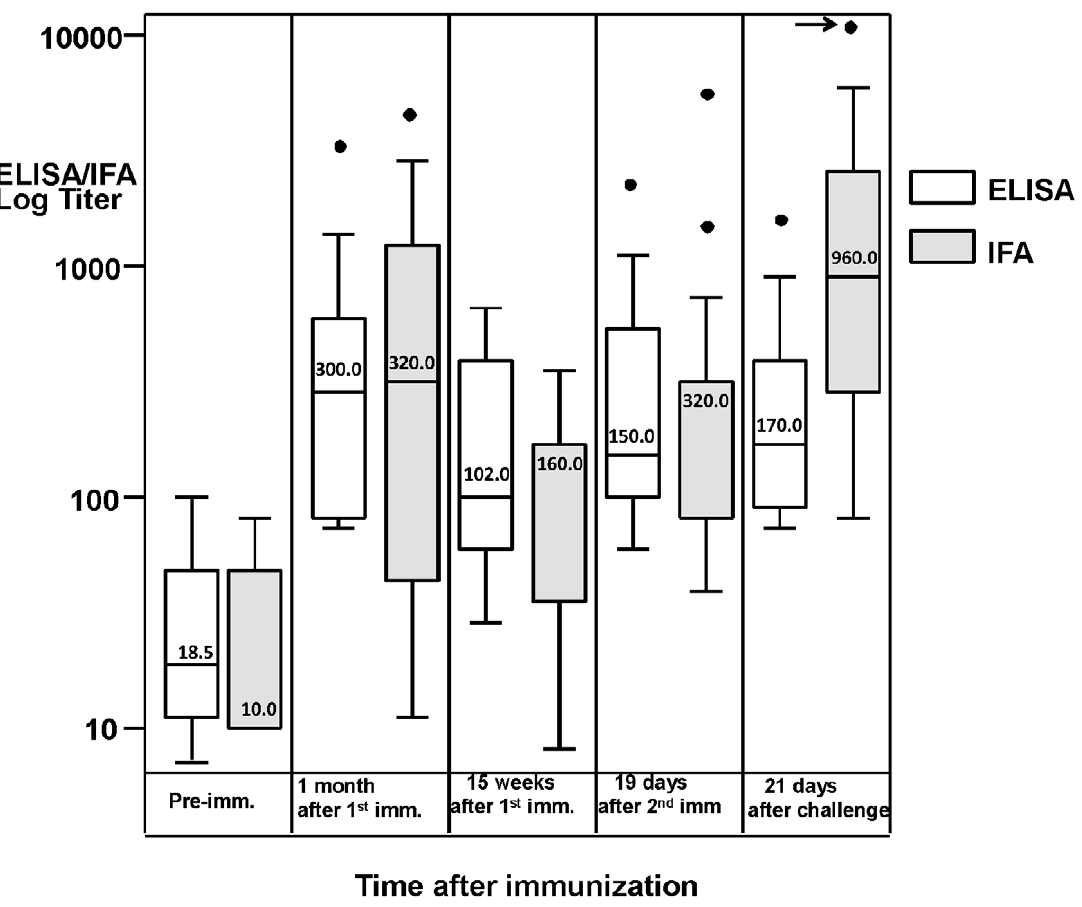
Figure 7. CSP ELISA and Sporozoite IFA activity. Box plots of the medians (50 th percentile) and 25 th and 75 th percentiles of ELISA and IFA activities prior to immunization, at 1 month and 15 weeks after the first immunization, 19 days after the second immunization, and 21 days after challenge. Whiskers spanning the first and third quartiles are at the base and top of each box, respectively, while the upper and lower horizontal bars at the ends of the whiskers represent the maximum and minimum values, respectively. Outliers are depicted by black dots; the arrow points to an outlier above the scale of the chart (1/20,480). The numbers give the value of the medians of each box, which in some cases are the same as the 25 th or 75 th percentile. When pre-challenge and post challenge titers were compared, ELISA remained similar (p=0.15) but titers significantly increased for IFA (p=0.02) using repeated analysis of log transformed values.